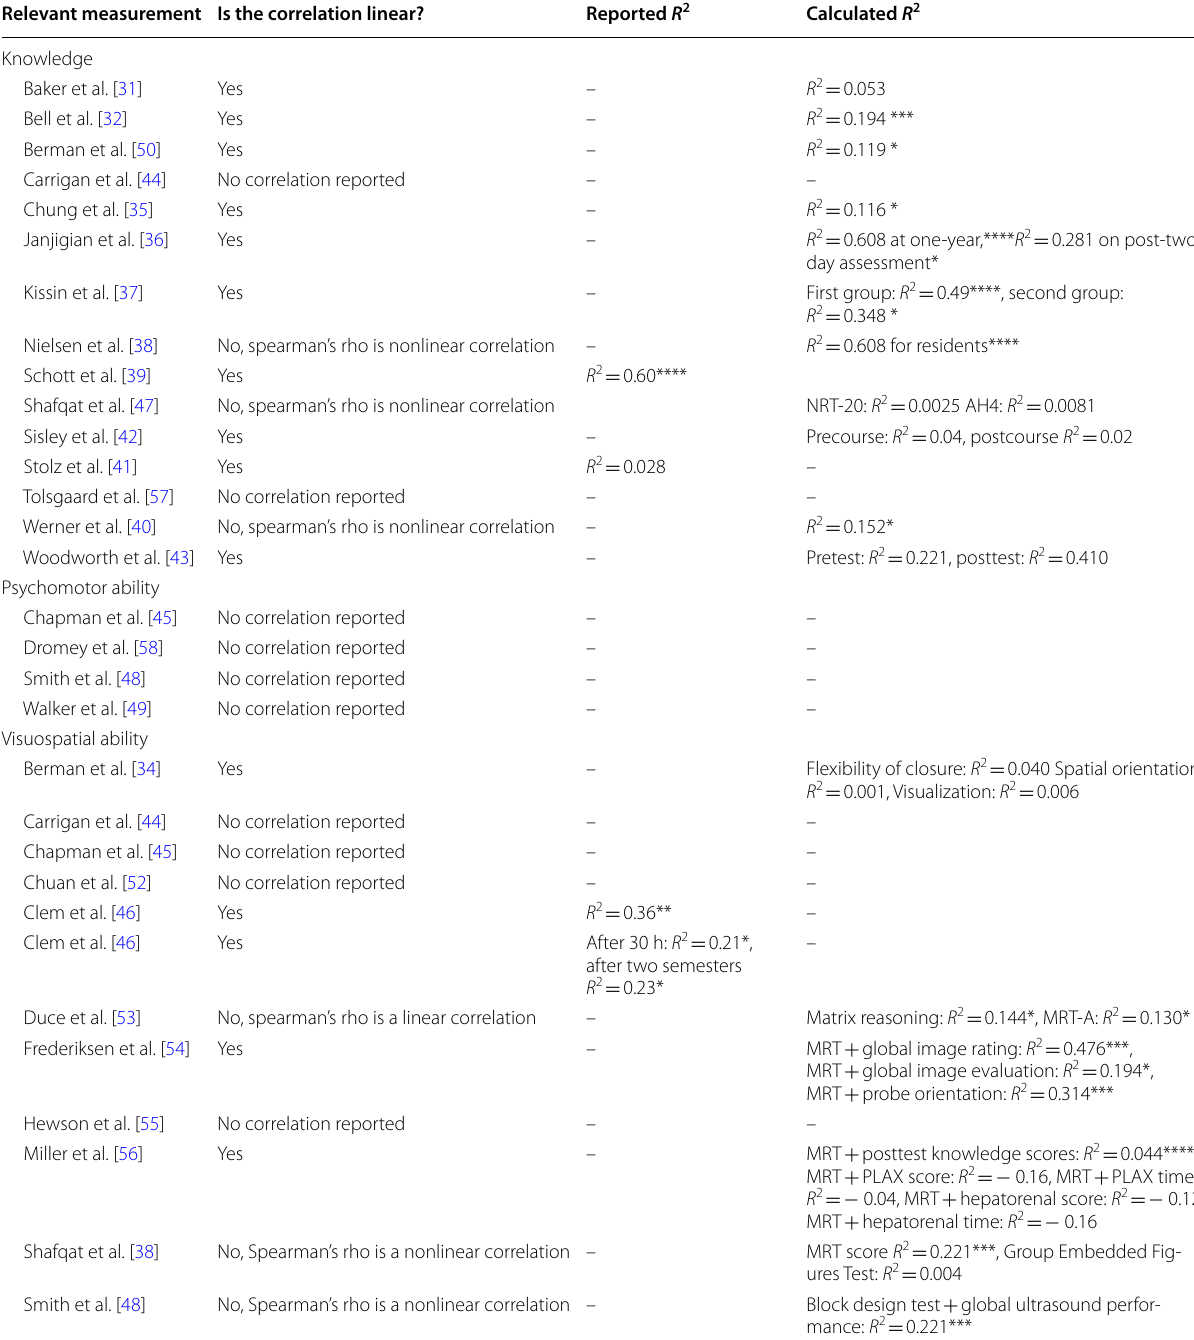
Table 2 Calculated and reported determination coefficients of the included